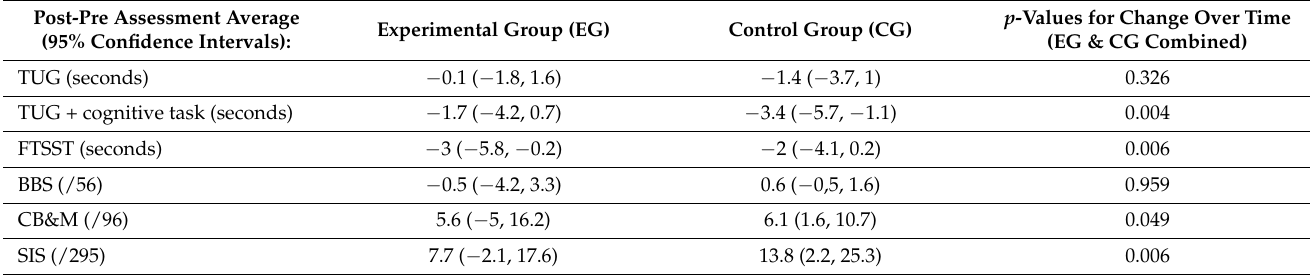
Table 3. Scores of scales and functional tests before-post telerehabilitation